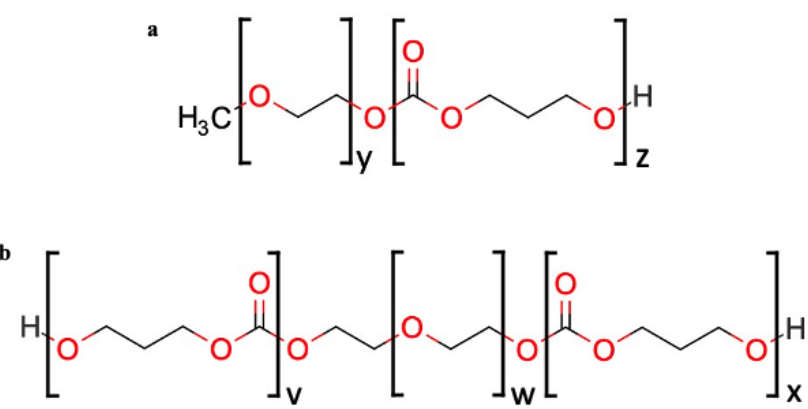
Figure 1. Chemical structure of a diblock ( a ) and a triblock ( b ) PEG–PTMC copolymer. Copolymers used in this study were coded as TBm-n and DBs-t, where m and s correspond to the molecular weight, in kDa, of the PEG and mPEG of TB and DB, respec- tively, and n and t correspond to the molecular weight, in kDa, of the total PTMC within the copolymer. For instance, TB1-9.3 stands for a triblock copolymer with 1 kDa PEG and 9.3 kDa PTMC; DB0.35-6.9 stands for a diblock copolymer with 0.35 kDa mPEG and 6.9 kDa